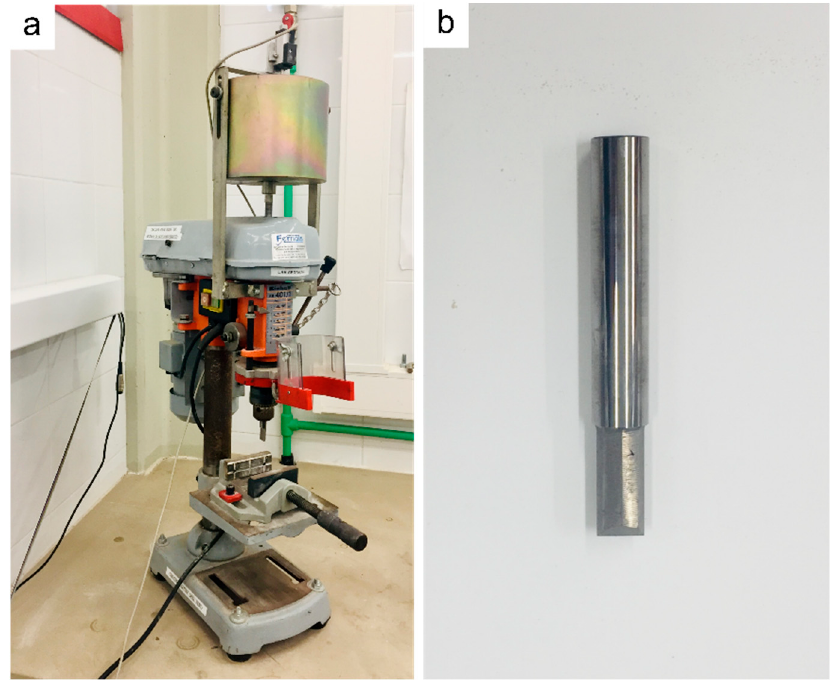
Figure 5. Laboratory equipment for Sievers’ J ‐ miniature drill test ( a ) and miniature drill bit ( b ) used in this research.